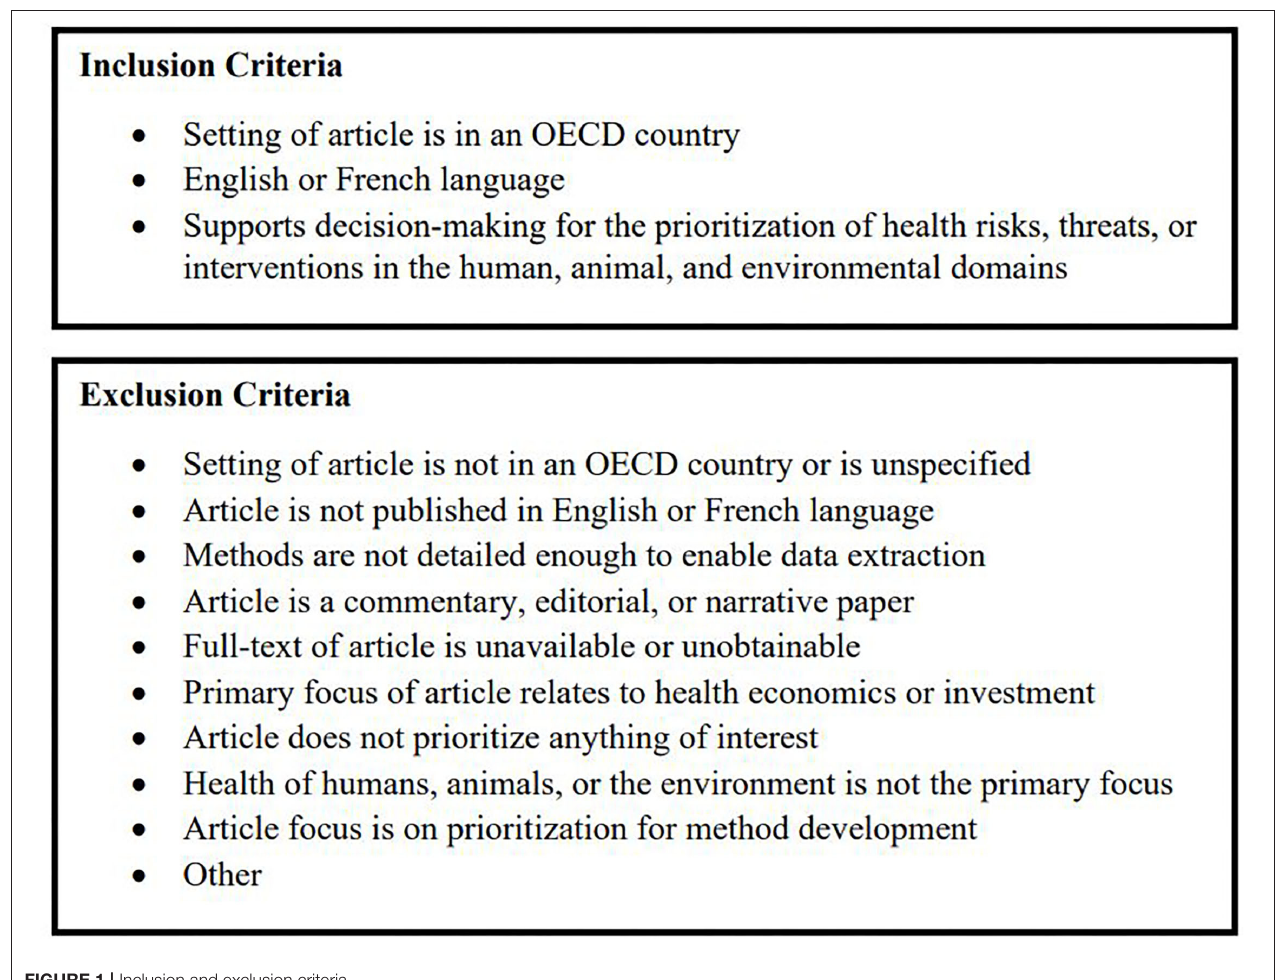
FIGURE 1 | Inclusion and exclusion